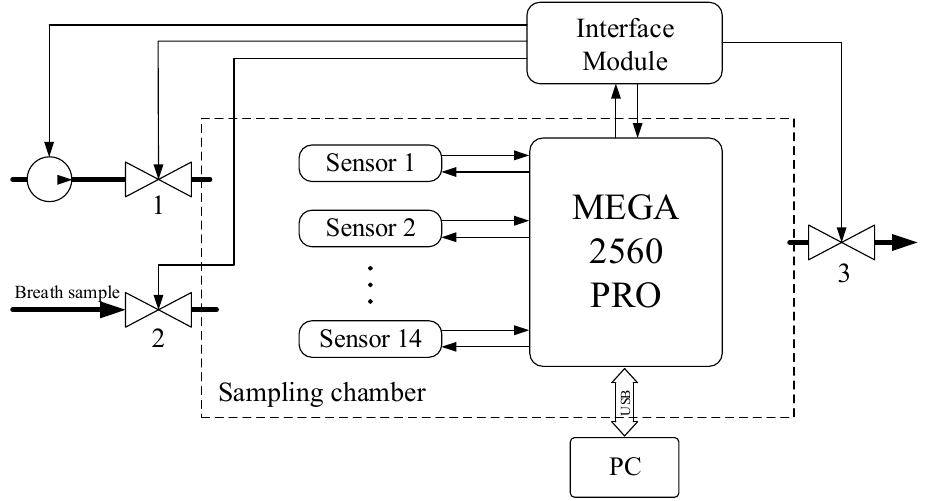
Figure 2. Generalized structure of the gas analytical system. Bold black arrows—gas flow; regular black arrows—control signal line; white circle—pump; dotted line box—sampling chamber; 1, 2 and 3—valves.